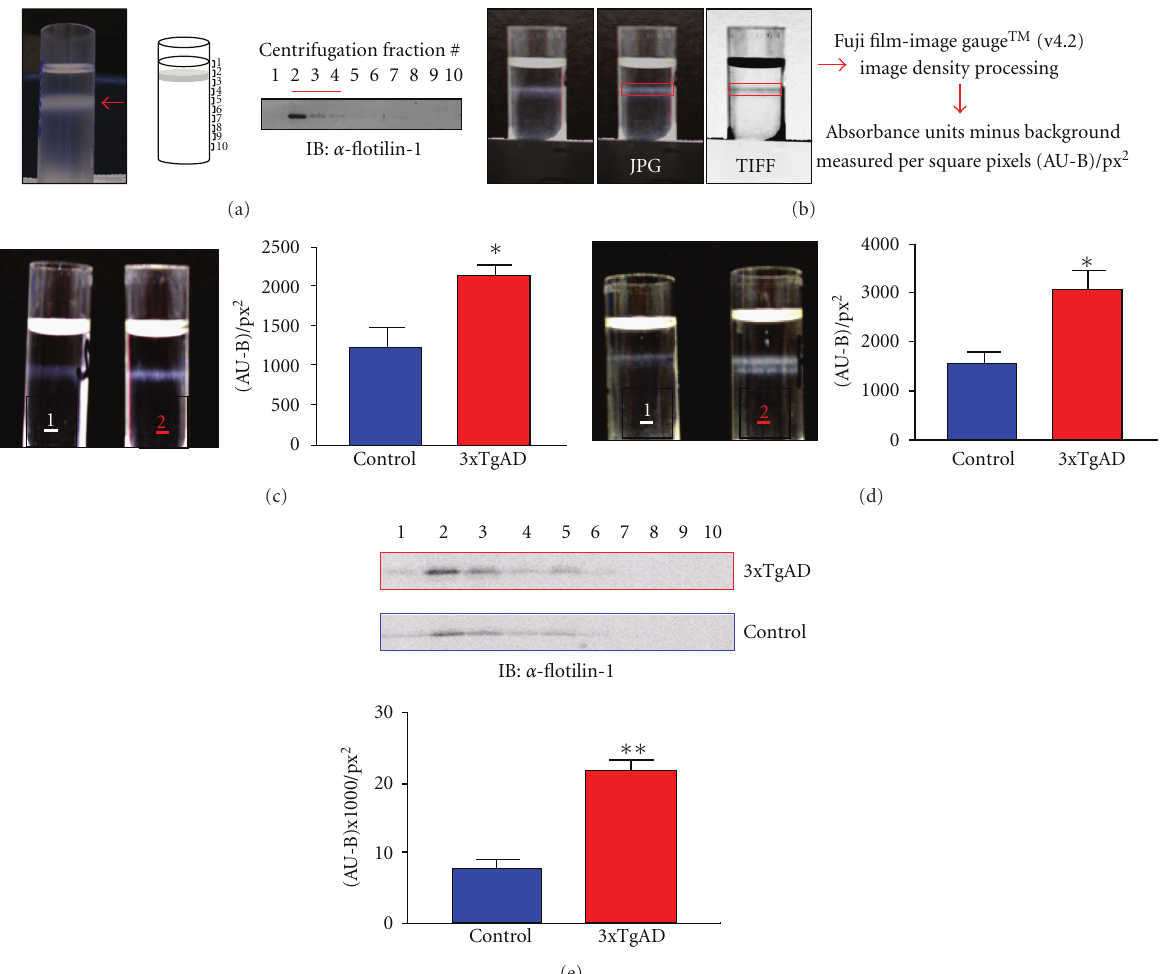
Figure 2: Quantification of detergent-resistant lipid rafts. (a) The pictorial panel depicts an image of iodixanol-separated detergent resistant membrane fractions (centered on red arrow), captured using a Nikon 3200 digital camera. The line diagram indicates the direction of collection of centrifugal fractions 1–10, and the associated Western blot for flotillin-1 demonstrates its enrichment in the raft fractions. (b) Captured Joint Photographic Expert Group (JPG) images were converted to a Tagged Image File Format (TIFF) version and imported to Image Gauge (v4.2) software and the specific area of interest (red box), that is, the detergent-resistant, flotillin-1-rich lipid raft band was quantified into absorbance units minus background absorbance per square pixel area ((AU-B)/px 2 ) values. (c) Representative set of male 8-month-old control (1) and 3xTgAD (2) mice detergent-resistant membranes isolated from plasma membrane fractions separated using an Iodixanol gradient. The associated histogram depicts mean ± s.e. (standard error) mean detergent-resistant membrane intensity ((AU-B)/px 2 ) from at least three separate control and 3xTgAD mice ( P = . 033, nonpaired, two-tailed t -test). (d) Representative set of male 16-month-old control (1) and 3xTgAD (2) mice detergent resistant membranes isolated from plasma membrane fractions separated using an Iodixanol gradient. The associated histogram depicts mean ± s.e. (standard error) mean detergent resistant membrane intensity ((AU- B)/px 2 ) from at least three separate C57-BL6 and 3xTgAD mice ( P = . 0224, non-paired, two-tailed t -test). (e) Representative flotillin-1 Western blot for the lipid raft fraction series for 3xTgAD (red outline) or control (C57-BL6: blue outline) mice. The associated histogram depicts mean ± s.e. (standard error) mean fraction 2 flotillin expression intensity ((AU-B)/px 2 ) from at least three separate C57-BL6 and 3xTgAD mice ( P = . 015, non-paired, two-tailed t -test).